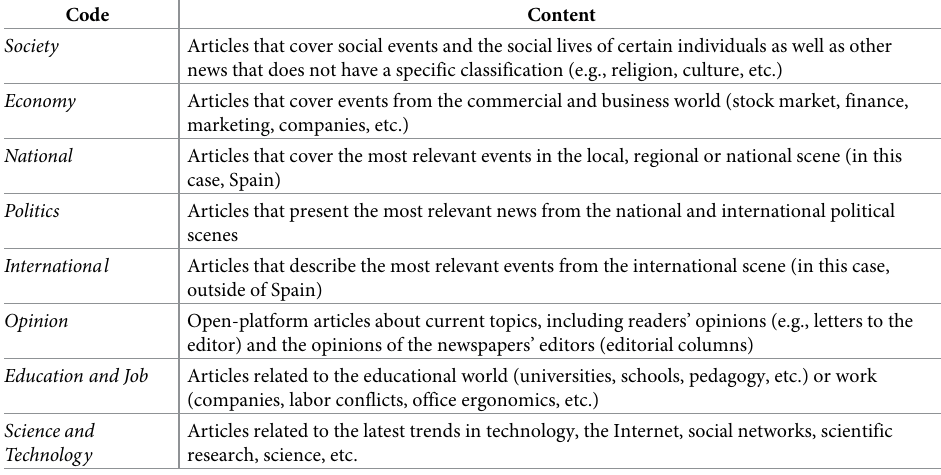
Table 7. Content of each code under the section